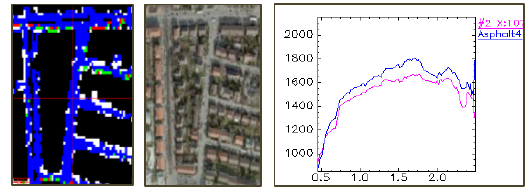
Figure 7. An example of a well classified area.